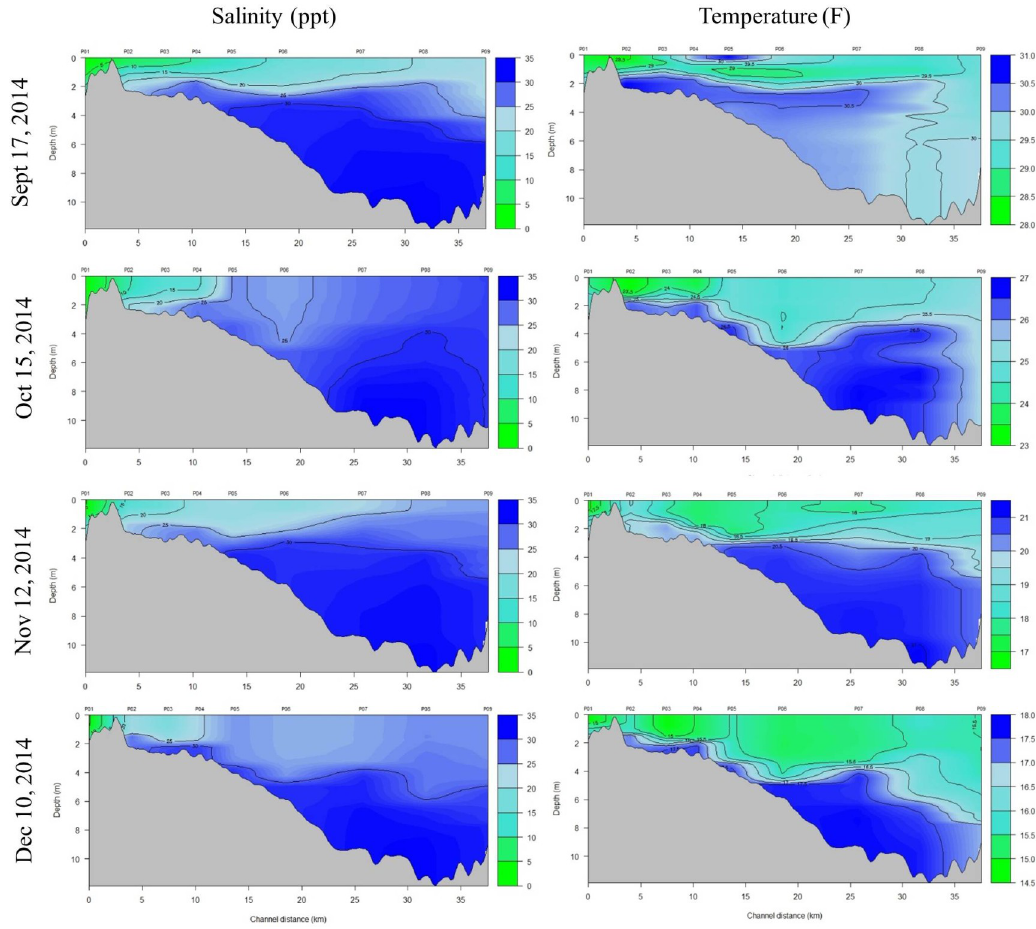
Fig 6. Salinity-depth profiles from EPA CTD stations along a transect that runs through the Escambia-Pensacola Bay system (see Fig 2) for September—December 2014. Station numbers are listed across the top (P01-P09) where P01 is located at the mouth of the Escambia River and P09 is at the mouth of Pensacola Pass. Escambia Bay opens into Pensacola Bay roughly at station P05; Channel distance is the distance from station